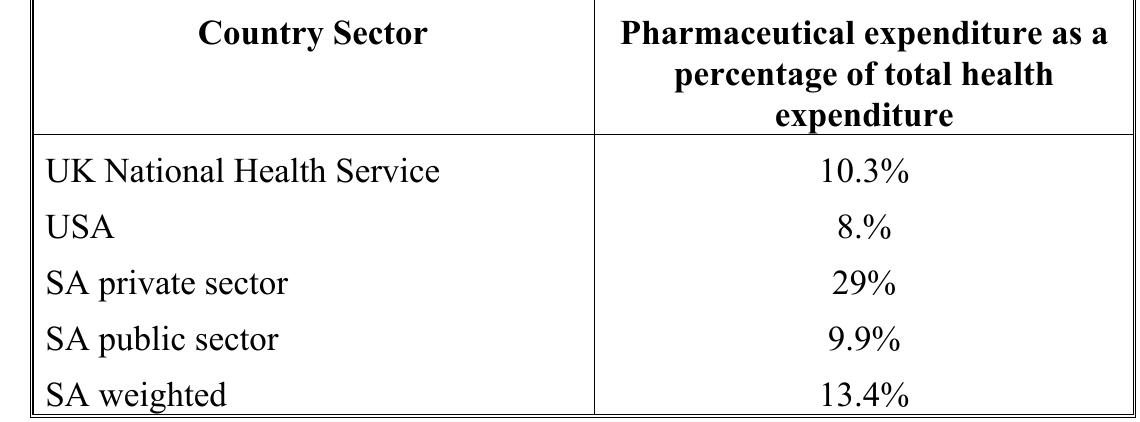
International comparisons of pharmaceutical expenditure as a proportion of total health expenditure Country Sector Pharmaceutical expenditure as